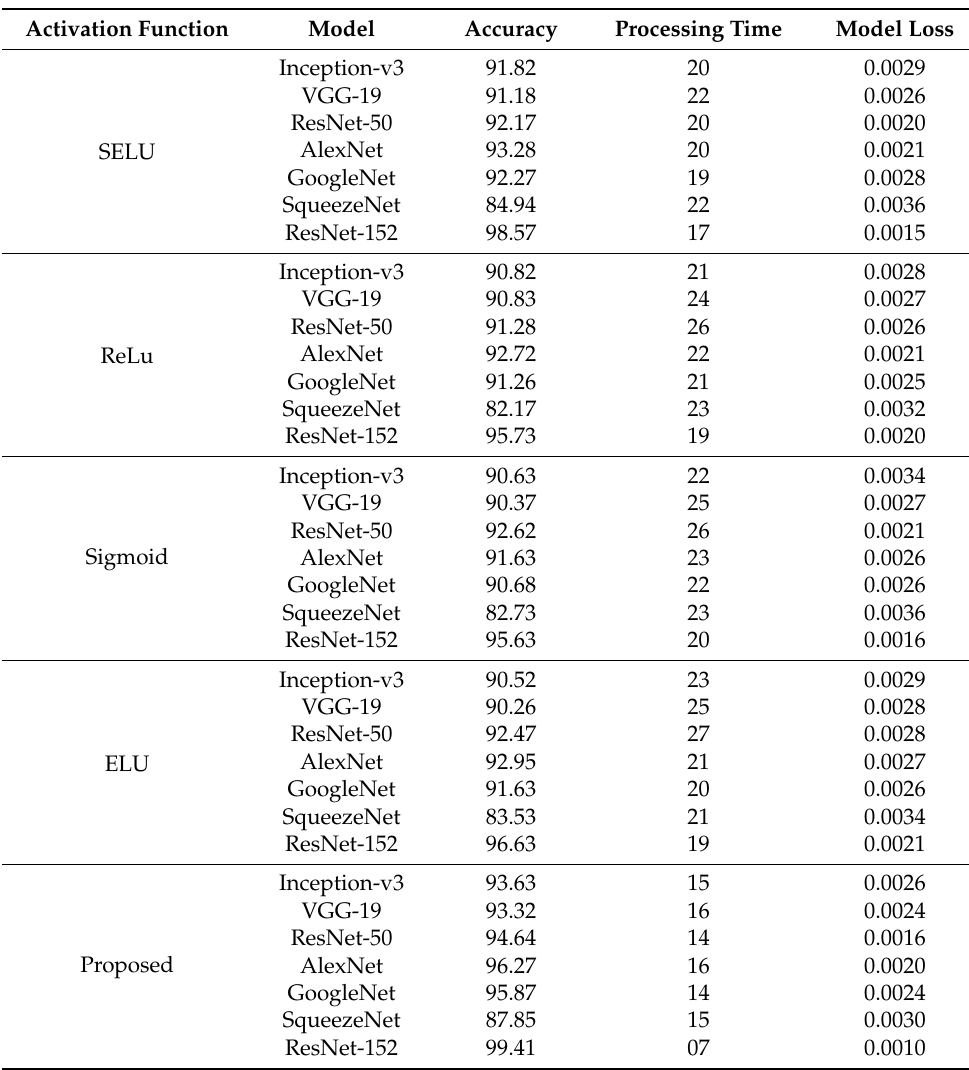
Table 6. Performance comparison of different existing activation functions with proposed activation function on Kaggle